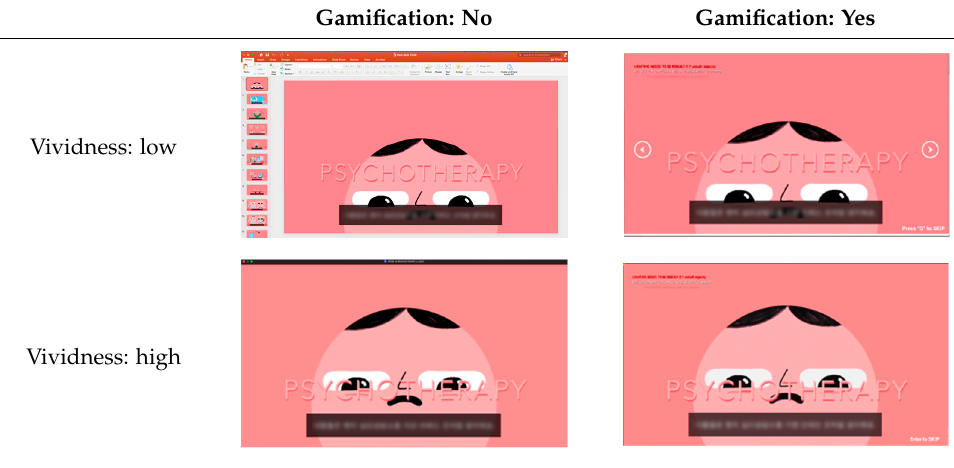
Table 2. Stimuli differing 2 × 2 between-subjects design.